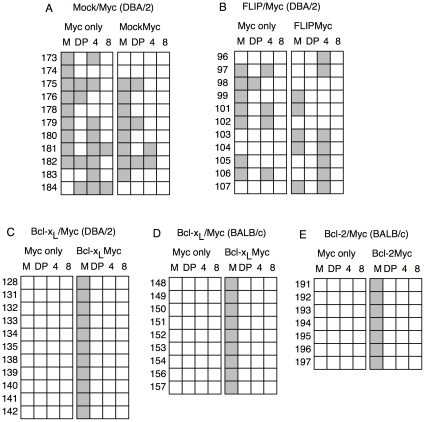
Tumor phenotype in Mock/MYC, FLIPL/MYC, BCL-XL/MYC and BCL-2/MYC recipient mice.Summary of flow cytometry analysis of spleen cells from moribund mice transplanted with HSC expressing (A) Mock-GFP/MYC-YFP into DBA/2 mice, (B) FLIPL-GFP/MYC-YFP into DBA/2 mice, (C) BCL-XL-GFP/MYC-YFP into DBA2 mice, (D) BCL-XL-GFP/MYC-YFP into BALB/c mice and (E) BCL-2-GFP/MYC-YFP into BALB/c mice. Left panel specify tumors expressing MYC-YFP only and right panel specify cells expressing MYC-YFP together with either Mock-GFP (A), FLIPL-GFP (B), BCL-XL-GFP (C and D) or BCL-2-GFP (E). Filled box indicate tumor phenotype. M indicates tumors of myeloid lineage, DP indicate CD4+CD8+ lymphoid tumors, 4 indicate CD4+ lymphoid tumors and 8 indicate CD8+ lymphoid tumors. Numbers correspond to identity of individual animal.